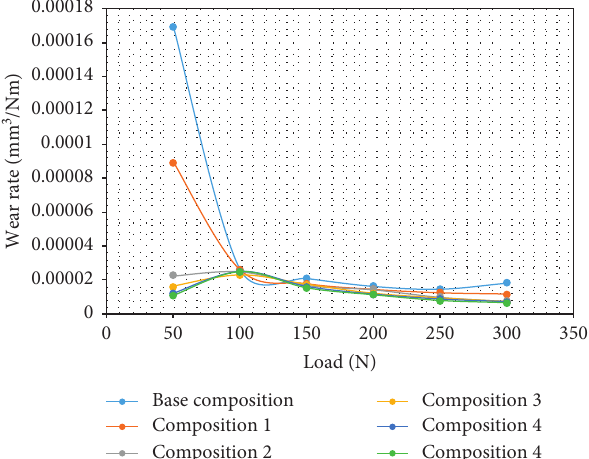
Figure 14: Wear rate v/s load at variable